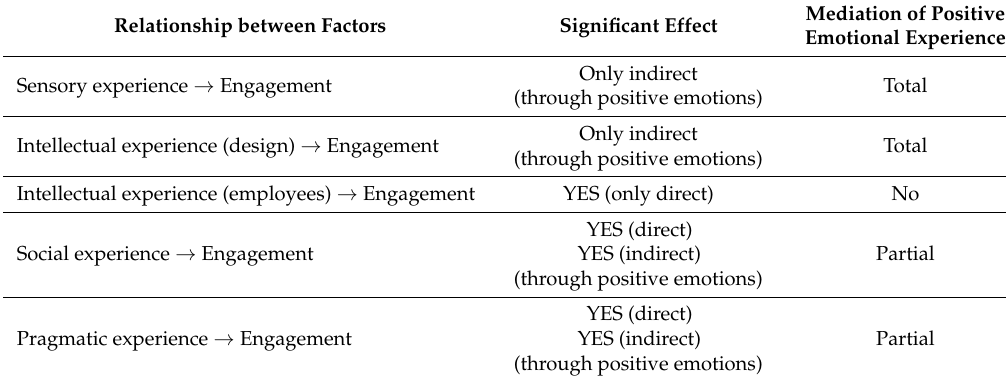
Table 6. Analysis of the mediating effect of positive emotional experience in the relationship between